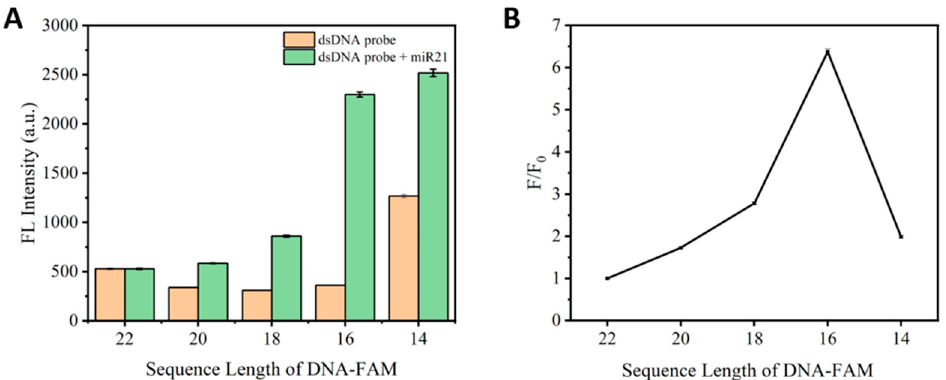
Figure 1. Length optimization of reporter DNA strand (DNA-FAM) for efficient strand displacement reaction towards miR21. ( A ) Effect of different reporter probe lengths for the fluorescence intensity of dsDNA probe (100 nM) or dsDNA probe (100 nM) supplemented with miR21 (100 nM) and ( B ) the ratio of recovered fluorescence after introducing the target miR21.